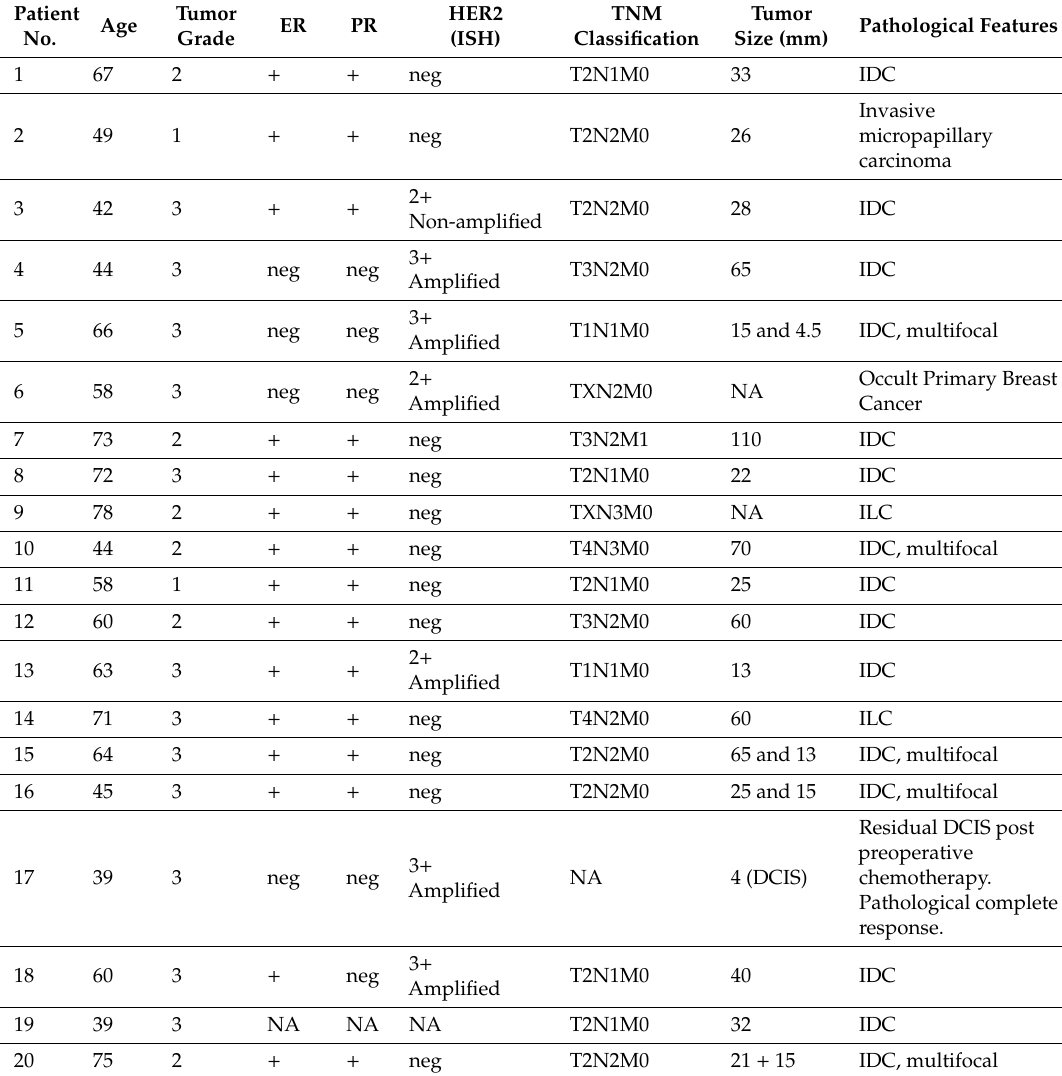
Table 1. Clinical characteristics of patients.